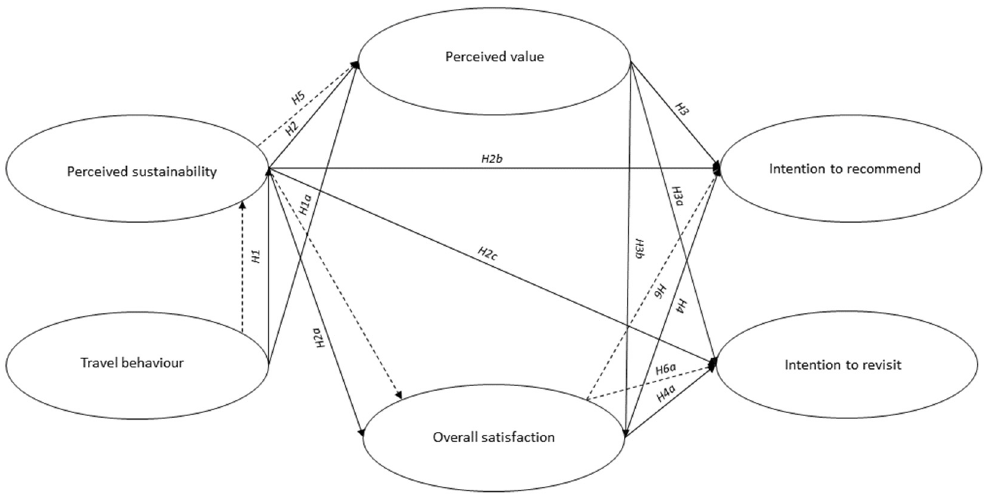
Figure 1. Conceptual Model. Connected lines: direct relationships among constructs; Dashed lines: indirect relationships among constructs.